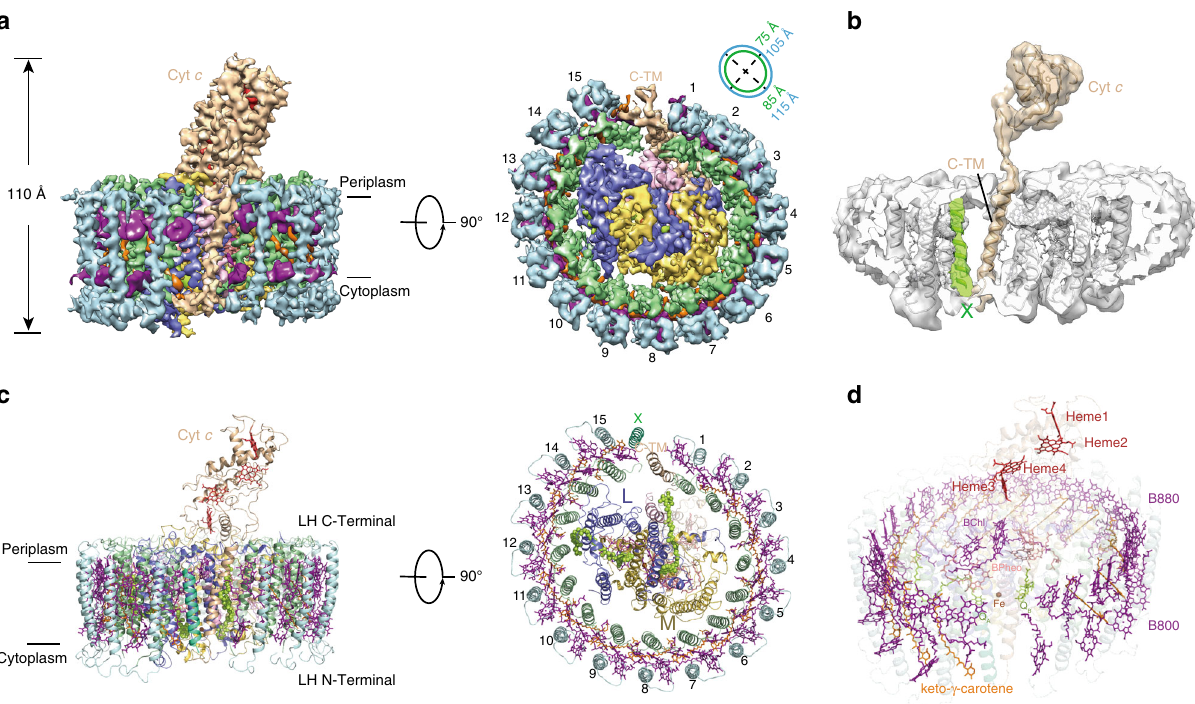
Fig. 1 Overall structure of RC – LH complex from R. castenholzii . a The cryo-EM map of the RC – LH complex is shown at side (left) or bottom-up (right) view. The dimensions of the RC – LH complex and LH ring are represented. b A low-pass (6 Å) fi ltered cryo-EM map of the RC – LH complex, with the Cyt c subunit and the subunit X highlighted in wheat and green. c Cartoon representation of the RC – LH complex. All the cofactors are shown as sticks except the menaquinone-11 and iron molecule, which are shown as spheres. They are presenting in the same direction as a . d Stick diagram showing arrangement of the cofactors in RC – LH complex in a tilted view. Color codes for all panels: pale green, α -apoproteins; pale cyan, β -apoproteins; wheat, Cyt c ; slate, L; yellow orange, M; light pink, the TM7 of the reaction center; green, subunit X; purple, BChls; orange, keto- γ -carotene; tv-red, heme; salmon, BPheos;